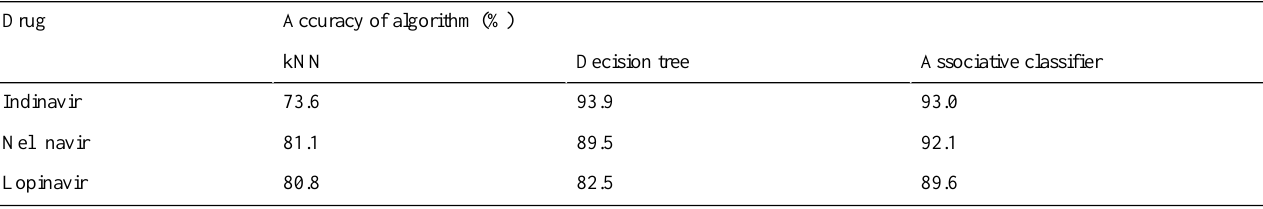
Table 4. Accuracy of predicting ARV drug resistance using k-nearest neighbor (kNN), decision tree [30], and associative classifier [31] algorithms.